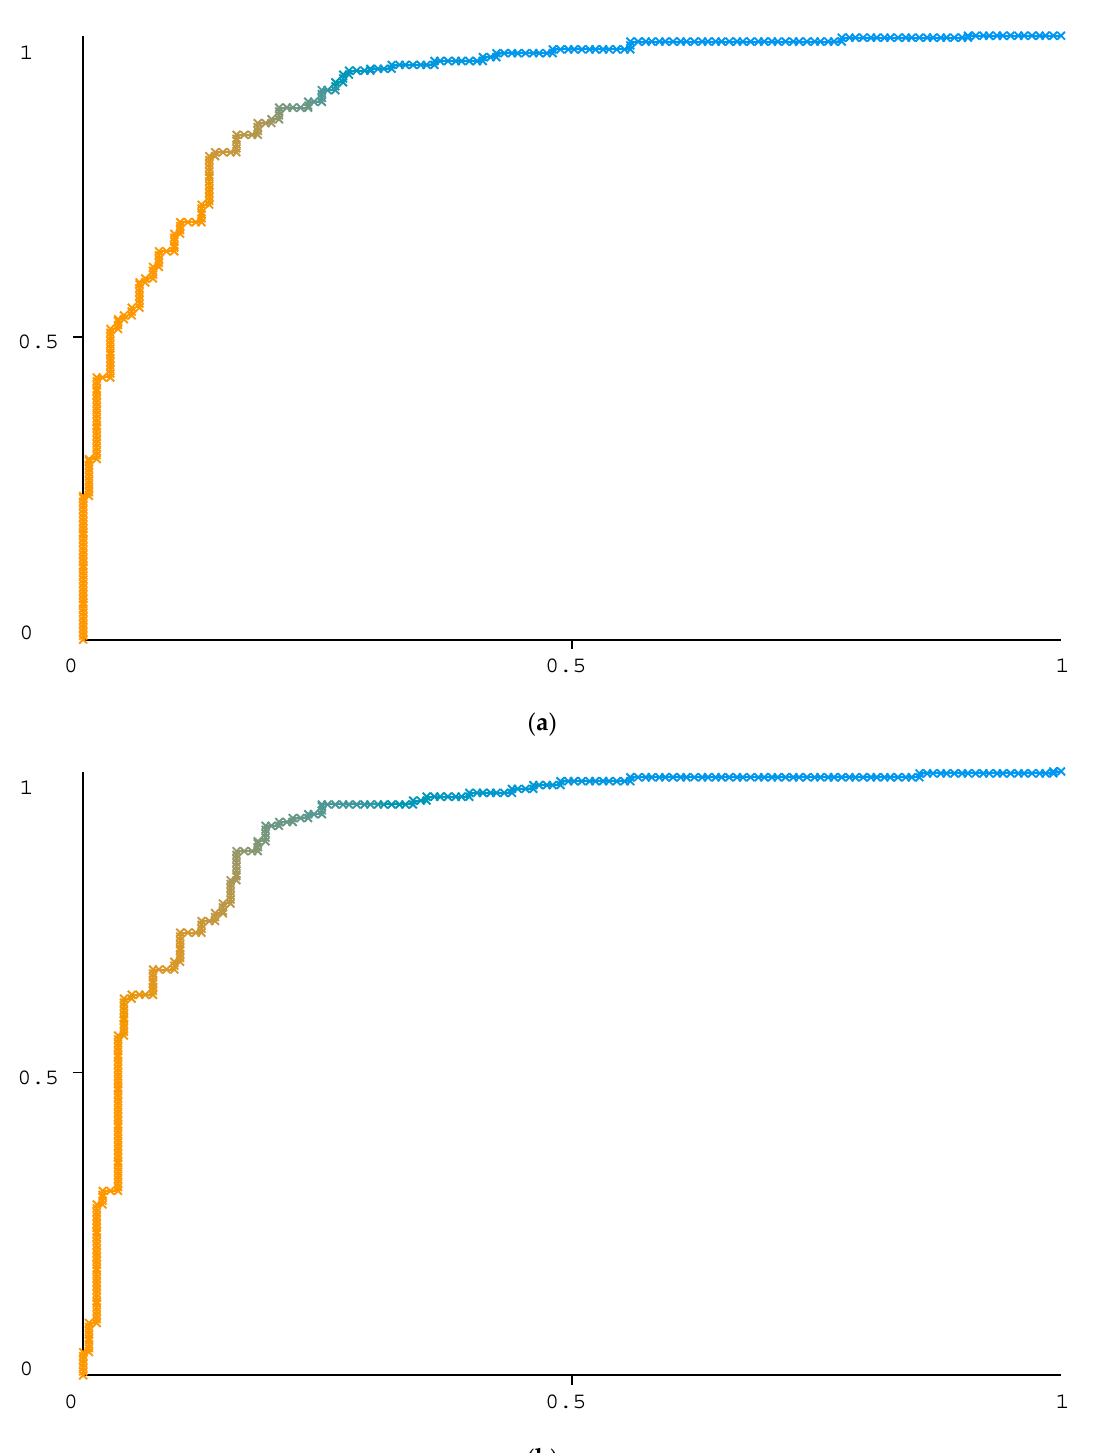
Figure 7. Performance metrics based on the optimal set obtained using the chi-squared attribute evaluation technique.